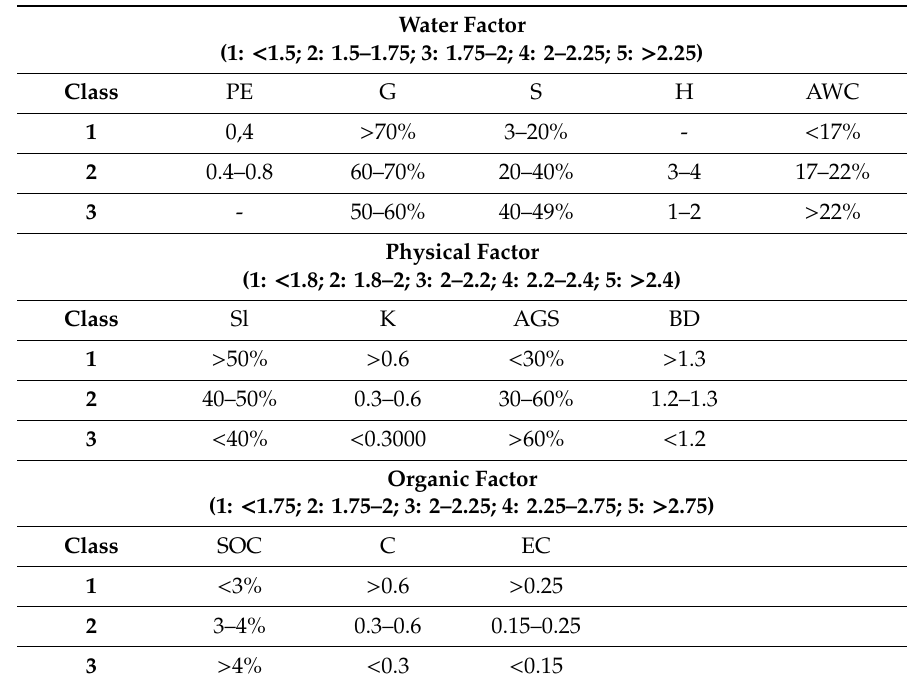
Table 1. Reclassification of the average values of the di ff erent properties and indicators used. PE = Permeability, G = Gravels, S = Sands, H = Hydrophobicity, AWC = Available Water Capacity, SL = Slope, K = K Factor (RUSLE), AGS = Structural Stability, BD = Bulk Density, SOC = Soil Organic Carbon, C = Factor C (RUSLE), and EC = Electrical